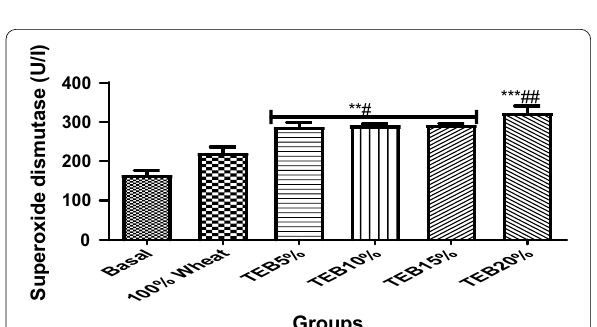
Fig. 12 Effect of enzymatic tacca–wheat biscuit on albino Wistar rats by superoxide dismutase. 100% Wheat: Rats fed with 100% wheat flour biscuit, TEB5%: Rats fed with 5% enzymatic tacca flour wheat flour biscuit, TEB10%: Rats fed with 10% enzymatic tacca flour 90% wheat flour biscuit, TEB15%: Rats fed with 15% enzymatic + tacca flour 85% wheat flour biscuit, TEB20%: Rats fed with 20% + enzymatic tacca flour